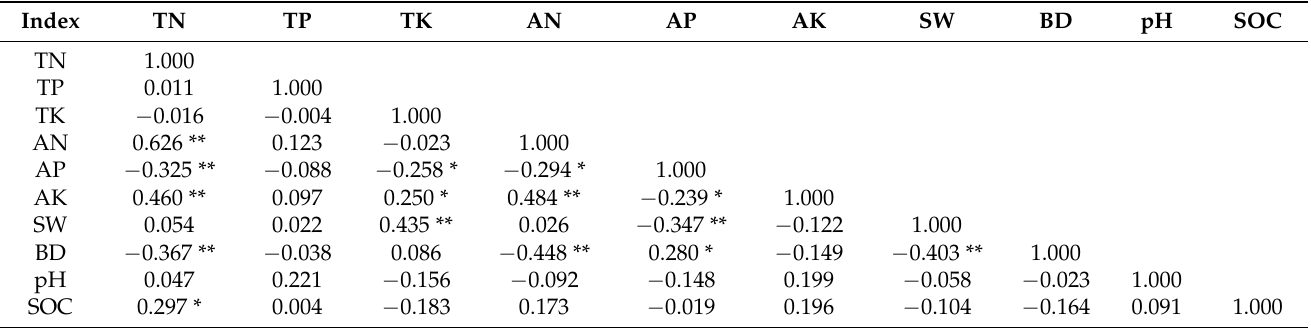
Table 4. Correlations between soil chemometrics in different-aged forests (TN, TP, TK, AN, AP, AK, SW, BD, and SOC repre- sent soil total nitrogen, total phosphorus, total potassium, available nitrogen, available phosphorus, available potassium, water content, bulk density, and soil organic carbon, respectively).